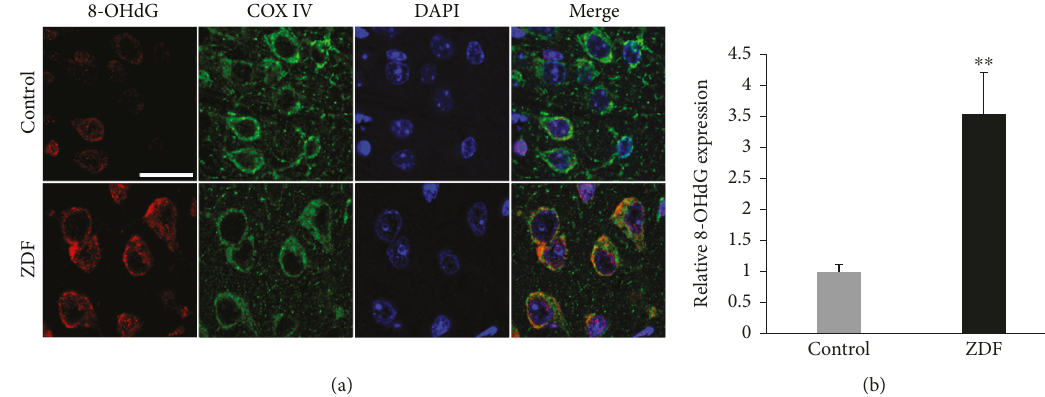
Figure 3: The expression of 8-OHdG in the auditory cortex of rats in the ZDF and control groups. (a) Representative images show the expression and localization of 8-OHdG (red) in the auditory cortex of rats in the ZDF and control groups using immunohistochemical staining. Scale bar = 20 μ m . (b) Quanti fi cation of 8-OHdG expression in the auditory cortex of rats in the ZDF and control groups. Data are expressed as mean ± SD ( n = 4 ). ∗∗ P < 0 01